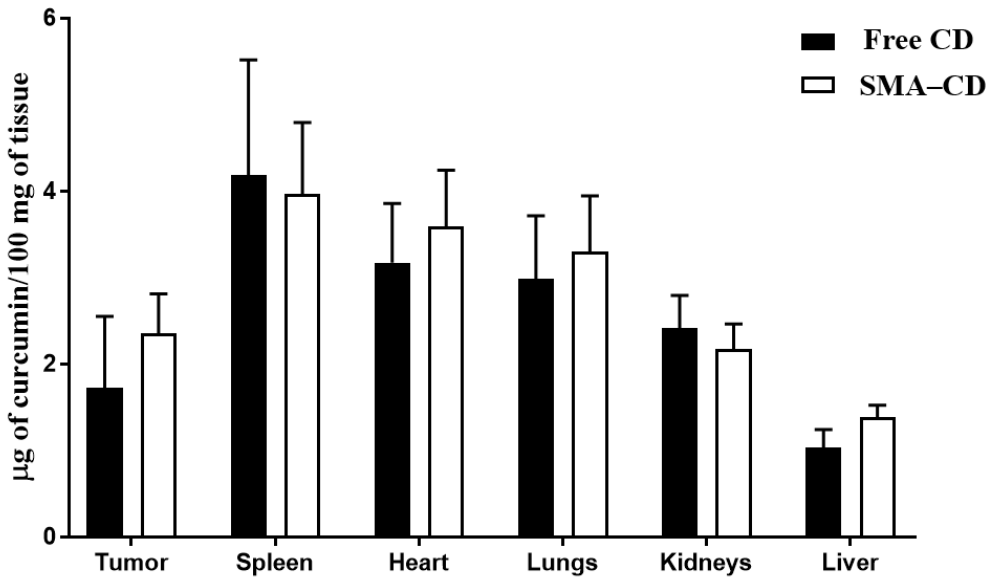
Figure 4. Quantitative determination of CD amount (µg) per 100 mg of tissue. Tissue distribution of CD at 24 h following intravenous injection of CD and SMA–CD to Balb/c mice bearing 4T1 tumors ( n = 6). Data are presented as the average ± standard